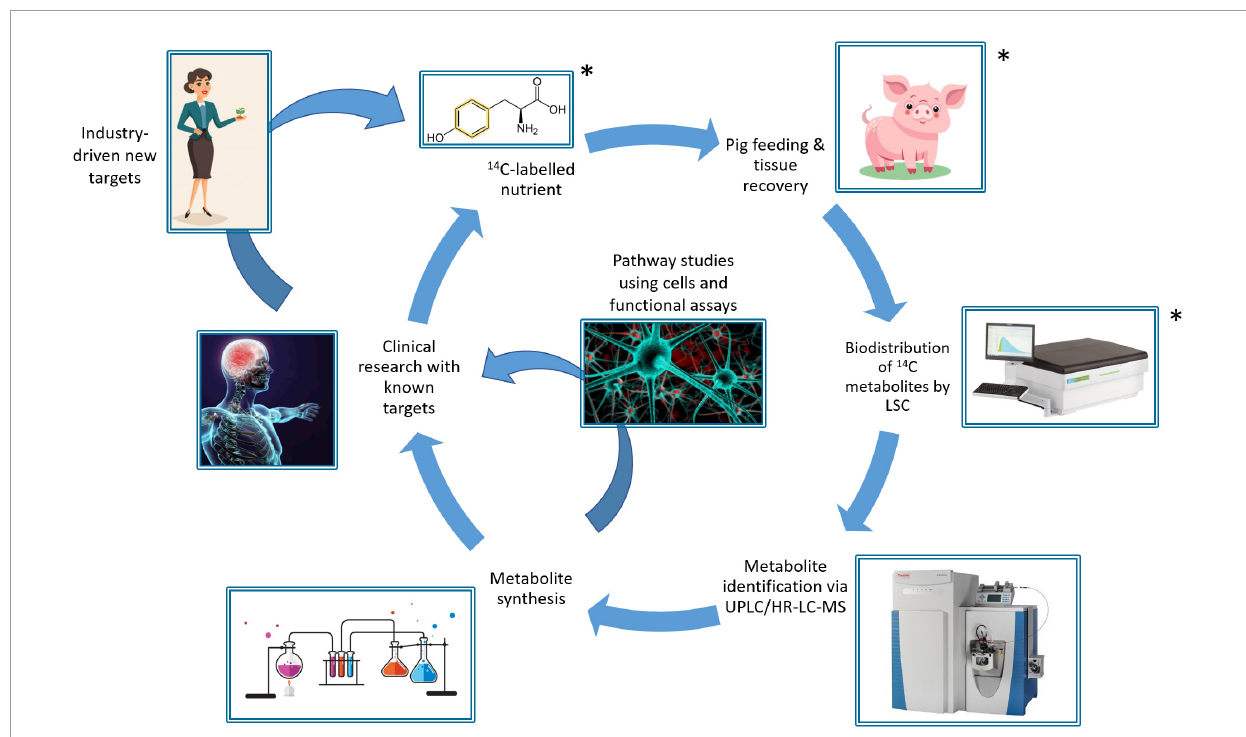
FIGURE1 Schematic of the 14 C-workflow for tracking the metabolic fate of bioactives/nutrients in food, showing the segments demonstrated in this study ( ∗